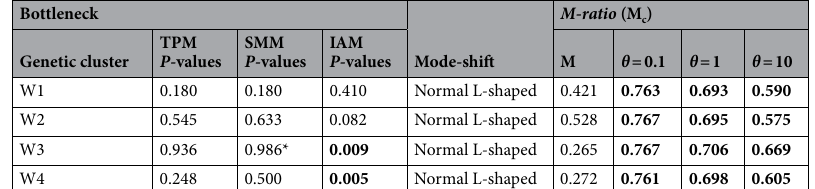
Table 4. Results of the bottleneck analysis. P -values of the one-tail Wilcoxon test for heterozygote excess are shown for the Two-Phase Model (TPM), Stepwise Mutation Model (SMM) and Infinite Allele Model (IAM). For the Mode-shift test, modes obtained for each population are indicated. Values of the observed M-ratio (M) and critical ratio (Mc) were estimated for three values of pre-bottleneck θ that correspond to N e values of 50, 500 and 5000, respectively. Values in bold suggest historic bottleneck events. *Significant p -values were obtained for heterozygote deficiency ( p < 0.05).